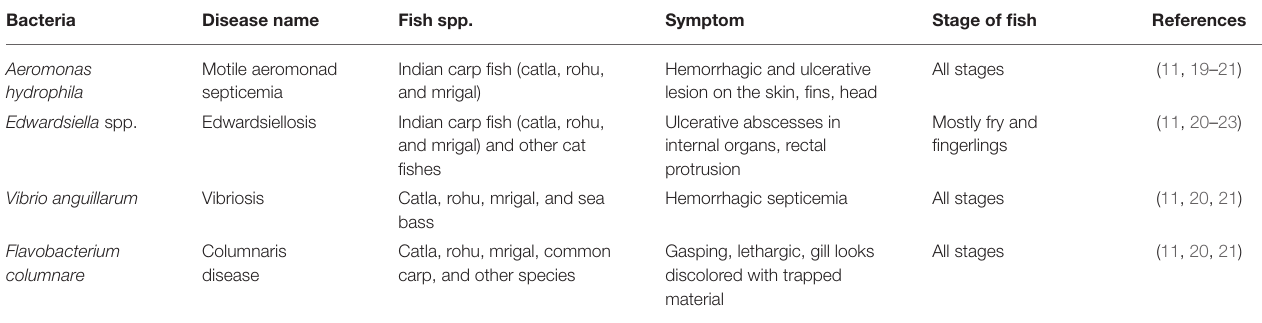
TABLE 1 | Major bacterial diseases causing fish diseases in Indian